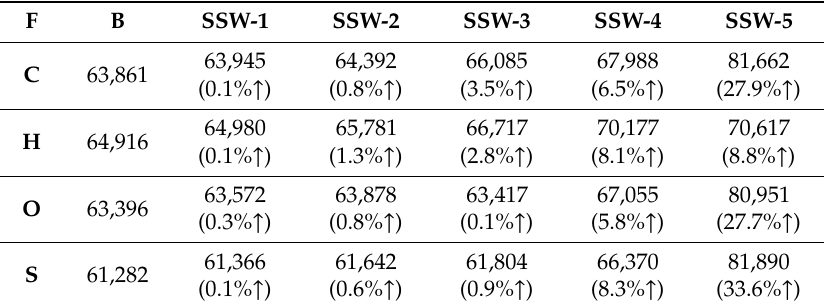
Table A6. Travel distance for residents in St. Francisco to destinations.